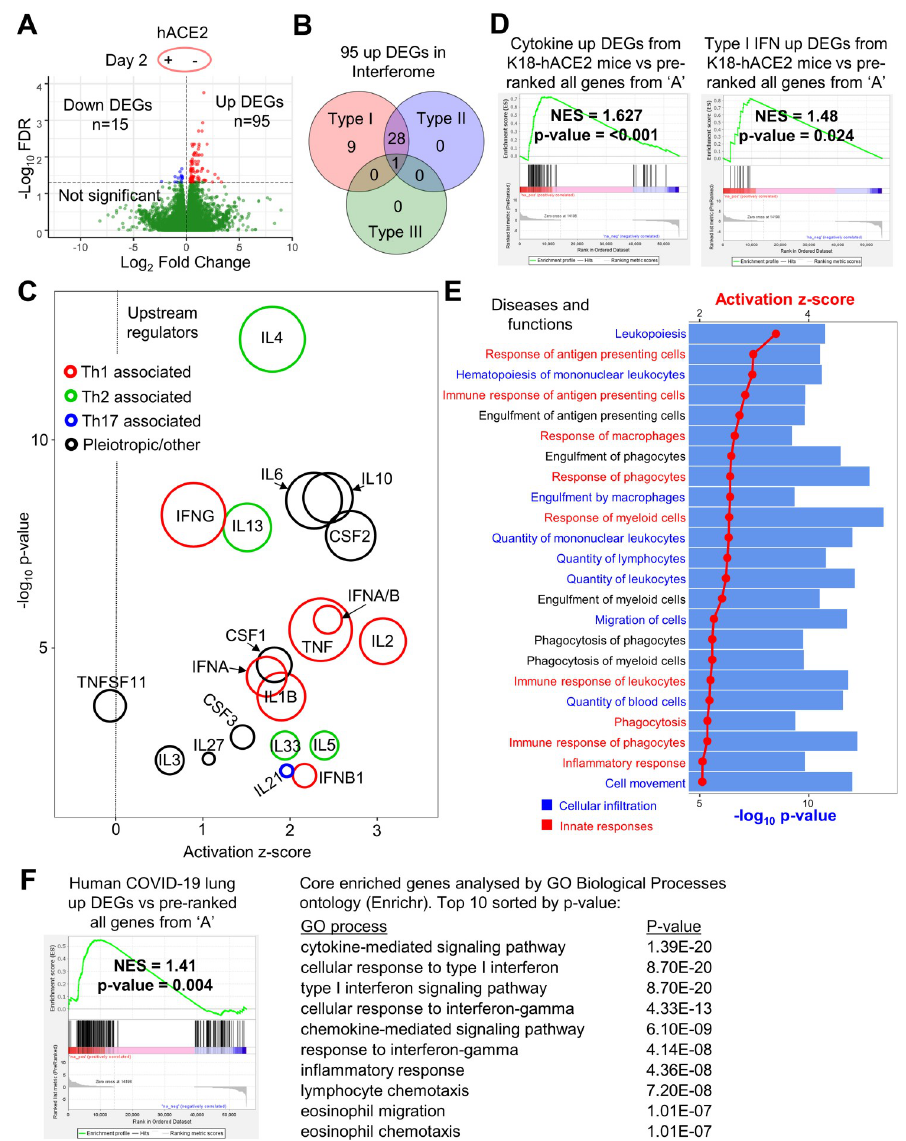
Fig 4. SARS-CoV-2 replication in hACE2-lentivirus transduced mouse lung induces inflammatory signatures by day 2 post-infection. A) Volcano plot of gene expression from RNA-seq analyses of lungs at day 2 comparing mice with and without hACE2-lentivirus transduction. Genes were considered DEGs if they had a FDR value < 0.05 (above horizontal dotted line) (see S1B–S1C Dataset for full gene and DEG lists). B) Interferome analysis of 95 up DEGs from ‘A’. 38 of 95 up DEGs (40%) were ISGs. Red = type I IFN, blue = type II IFN, green = type III IFN (see S1D Dataset for full Interferome ISG list). C) Cytokine signatures identified by IPA USR analysis (see S1E and S1F Dataset for full and cytokine only USR lists) of 110 DEGs identified in ‘A’. Circle area reflects the number of DEGs associated with each USR annotation. USRs were grouped into three categories; red = Th1 associated, green = Th2 associated, blue = Th17 associated, and black = pleiotropic/other. The vertical dotted line indicates activation z-score of 0. D) GSEAs for cytokine-related DEGs or type I IFN-related DEGs (S1G Dataset) from Winkler et al. supplemental data [9] against the pre-ranked all gene list (S1B Dataset). Winkler et al. compared infected versus uninfected K18-hACE2 transgenic mouse lung at day 2 post infection by RNA-Seq and provided DEG lists for these categories in their supplementary material. Normalised enrichment score (NES) and nominal p-value are shown. E) IPA diseases and functions analysis (see S1H–S1I Dataset for full lists) of 110 DEGs identified in ‘A’. The 23 annotations with the most significant p-value and with an activation z-score of > 2 were plotted with dots/lines indicating activation z-score and bars indicating– log 10 p-value. Annotations were grouped into two categories; cellular infiltration (blue) and innate responses (red). F) GSEA for DEGs from human COVID-19 lungs versus healthy control from Blanco-Melo et al. [64] against the pre- ranked (by fold change) all gene list (S1B Dataset). Normalised enrichment score (NES) and nominal p-value